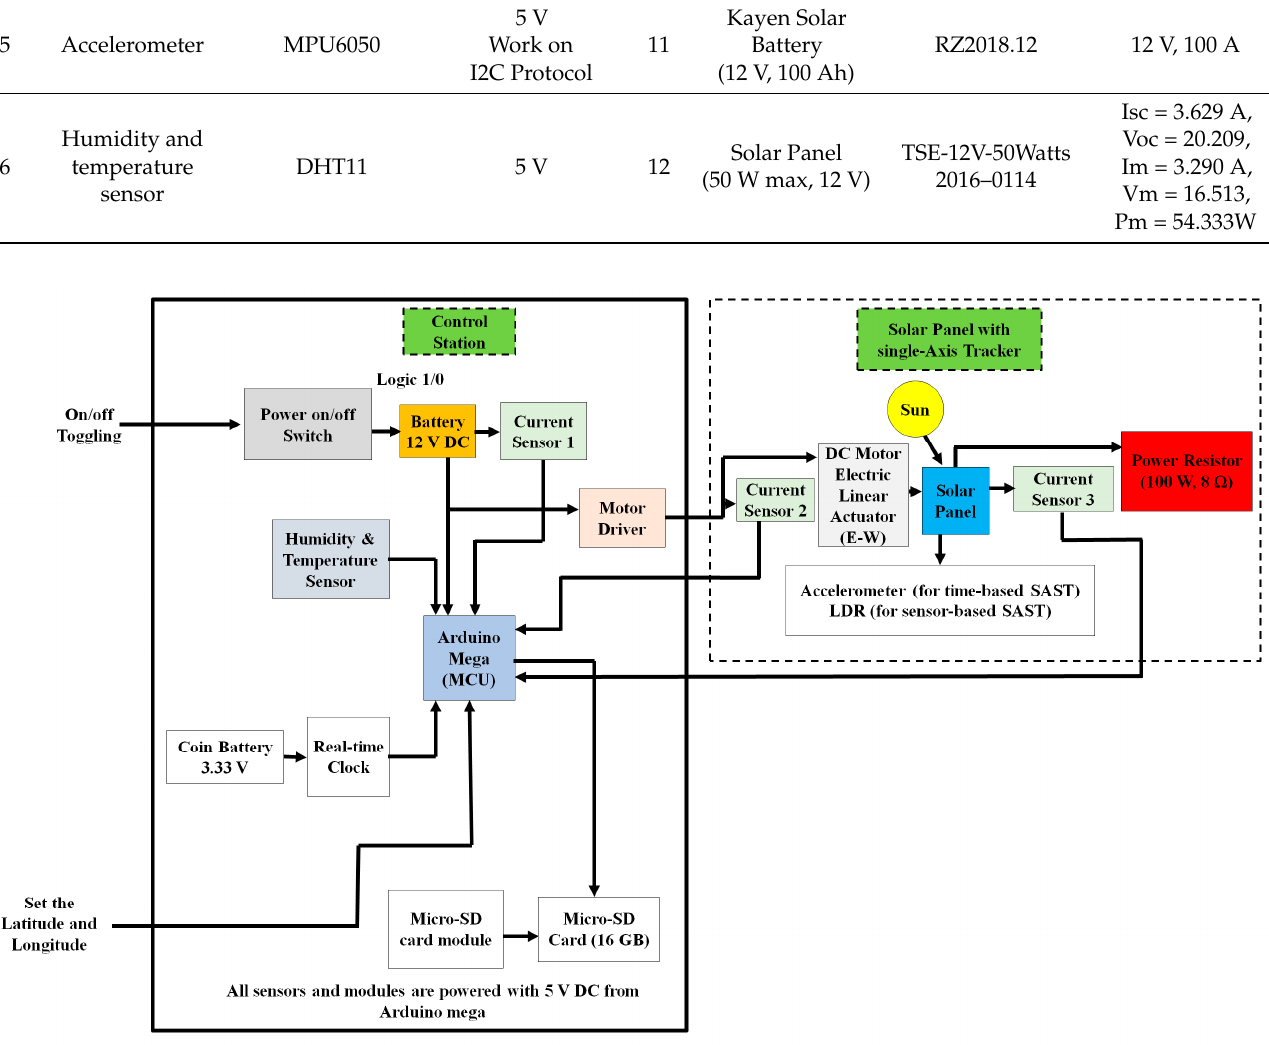
Figure 4. The functional electrical diagram of the setup.